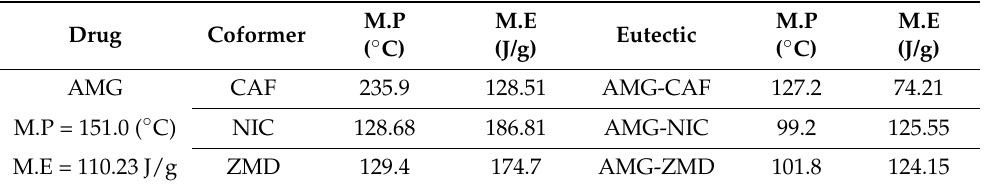
Table 1. Melting point (M.P) and melting enthalpy (M.E) of drug AMG, the coformers and their eutectic compositions.